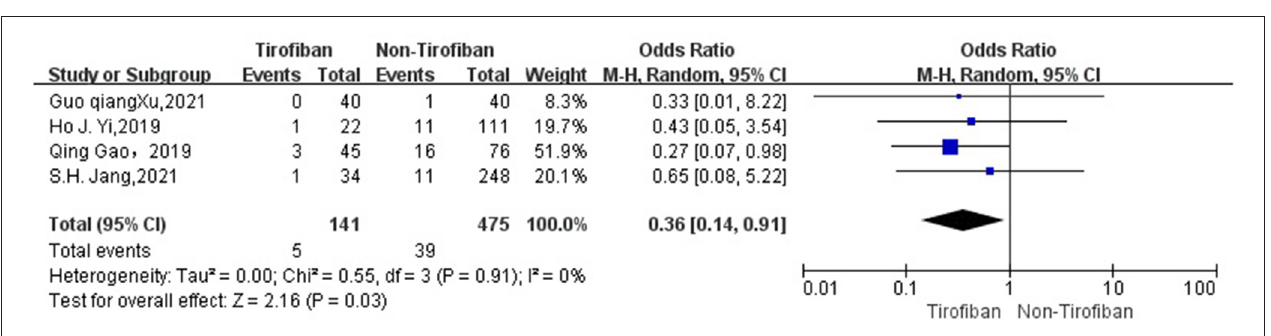
FIGURE 7 | Forest plot and meta-analysis of Postprocedural